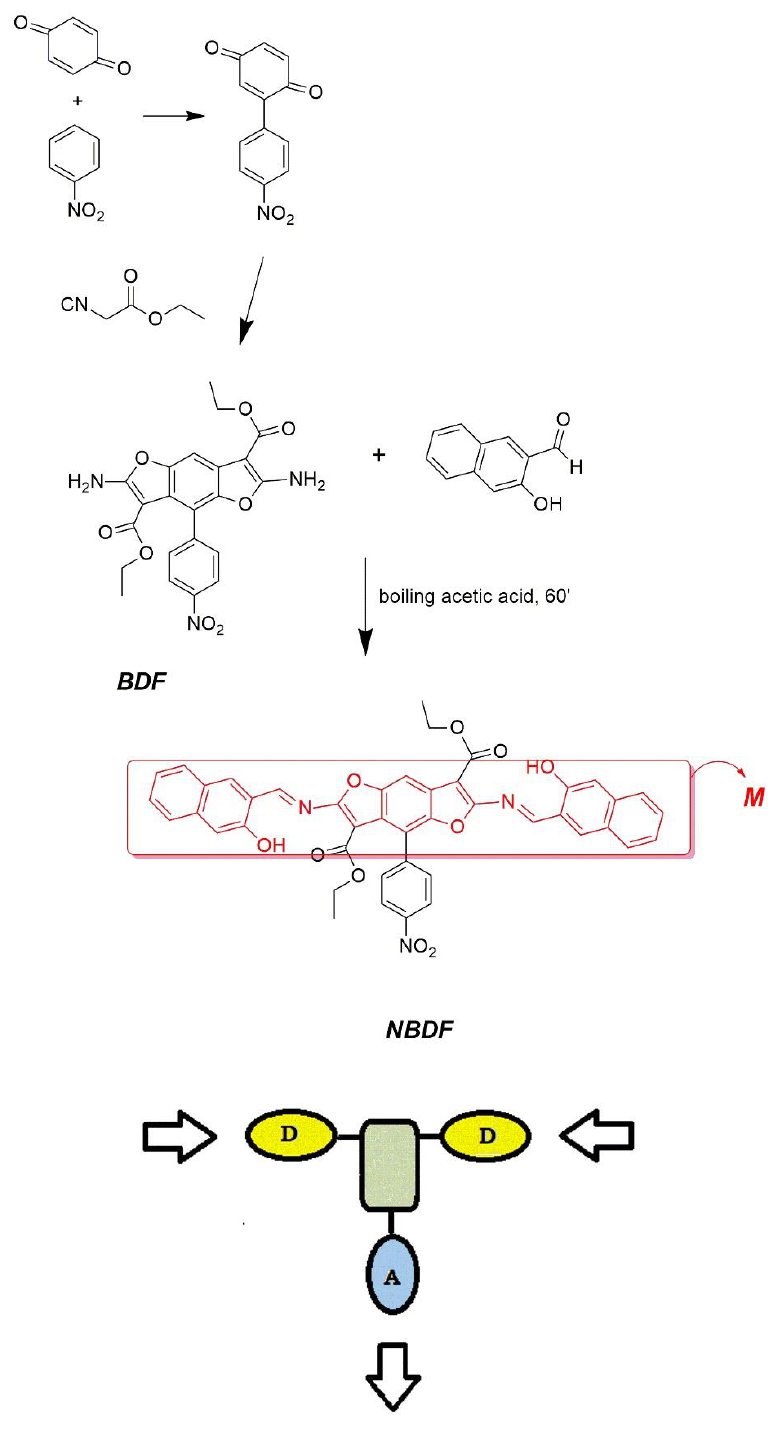
Scheme 1. Synthetic route to the target compound NBDF . D-A-D T-shaped molecule schematically represented. M is the plane containing the diamino-benzodifuran rings condensed with the two 3-hydroxy-2-naphthaldehyde moieties, i.e., the fragment depicted in